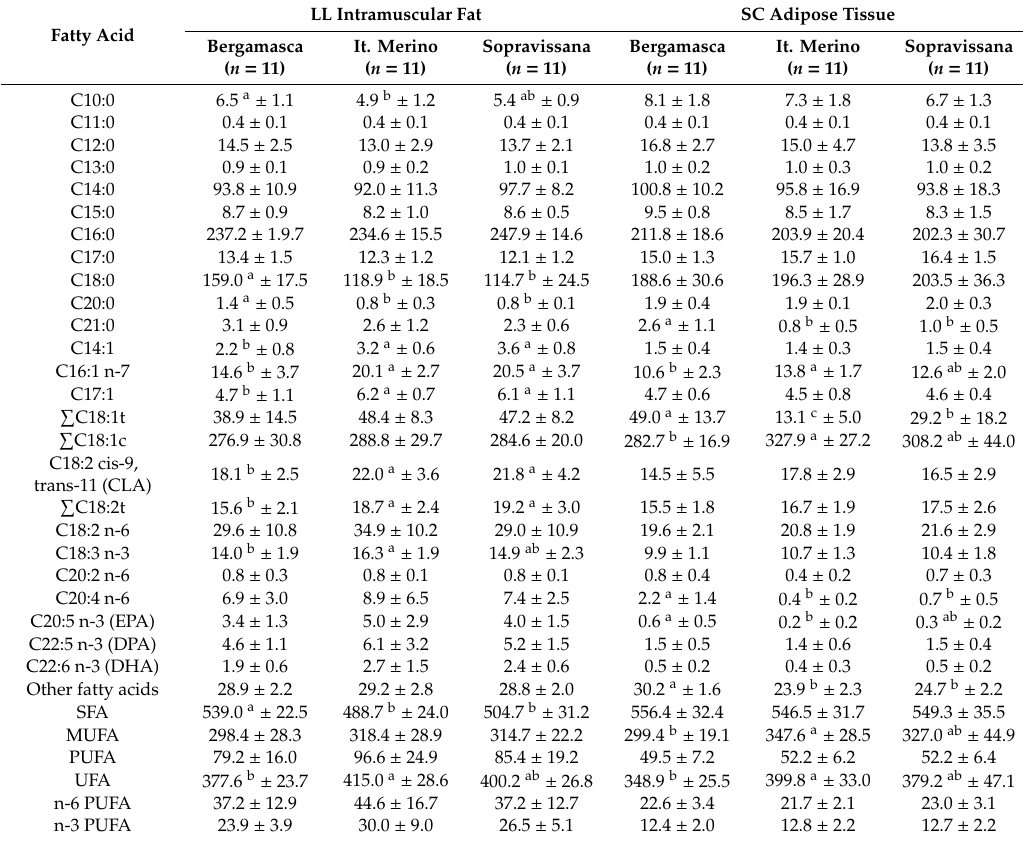
(cid:80) C18:1t = sum of unidentified